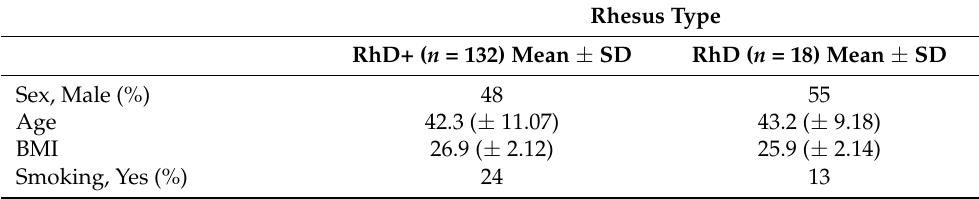
Table 2. Baseline characteristics of all study participants ( n = 150) according to Rhesus